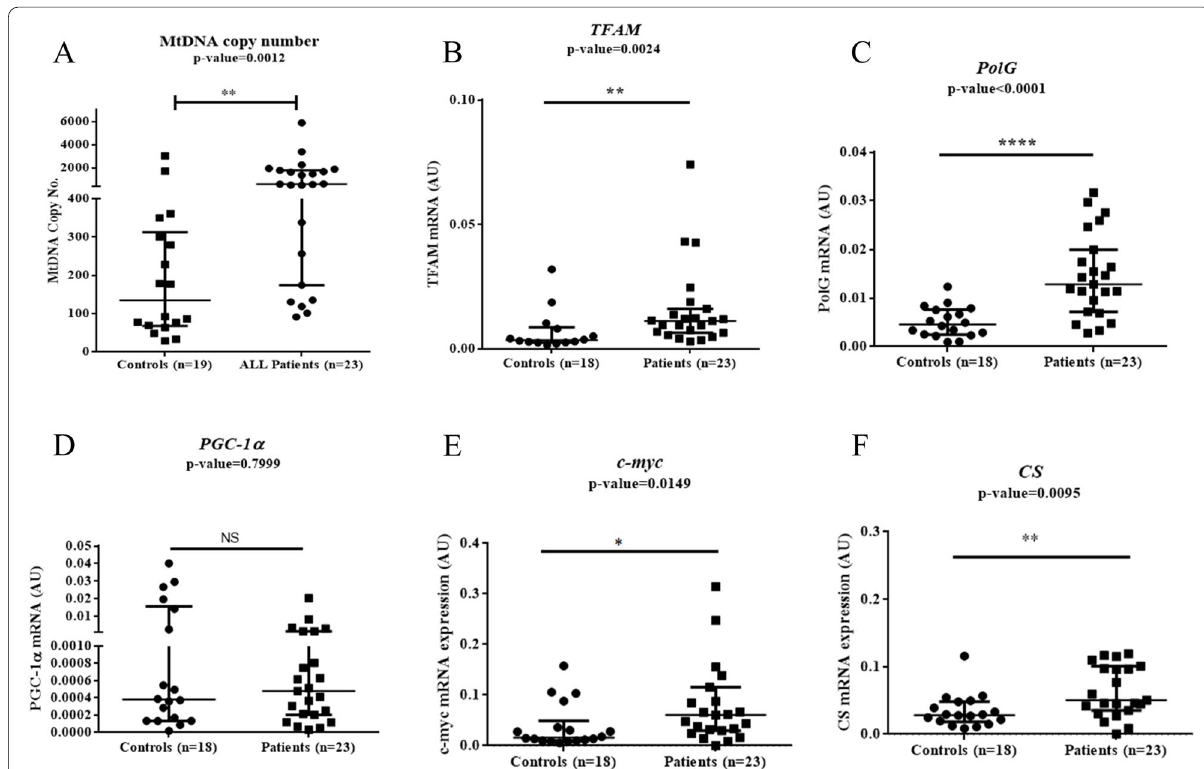
Fig. 4 Scatter plots for mtDNA copy number and mRNA expression of TFAM, POLG, PGC-1α , c-myc, and CS genes in ALL patients and healthy controls. A MtDNA copy number analysis in ALL patients and healthy controls ( p controls ( p 0.0024). C POLG gene expression in ALL patients and healthy controls p < 0.0001). D PGC-1α gene expression in ALL patients and = healthy controls ( p 0.7999). E c-myc gene expression in ALL patients and healthy controls ( p = healthy controls ( p